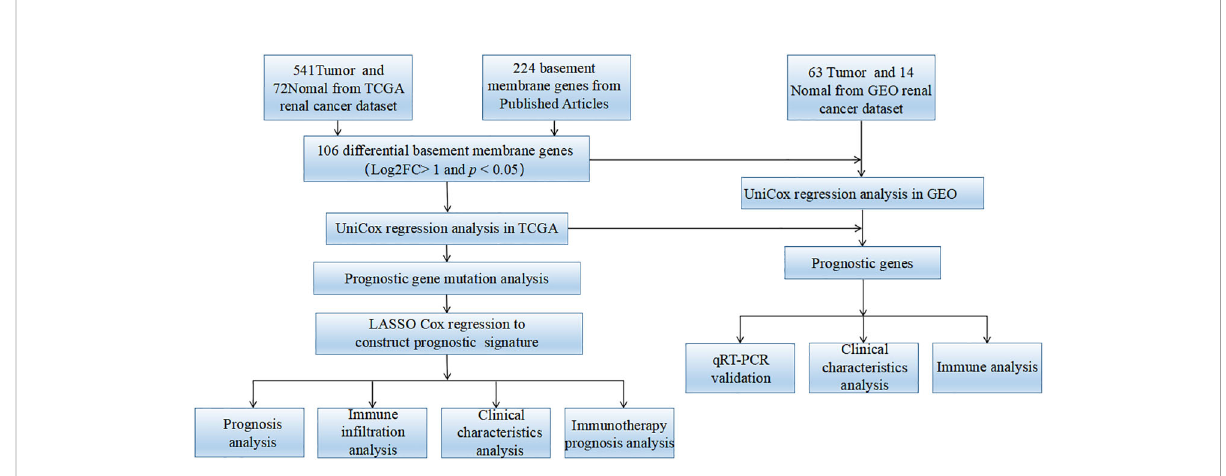
FIGURE 1 The fl ow diagram of this